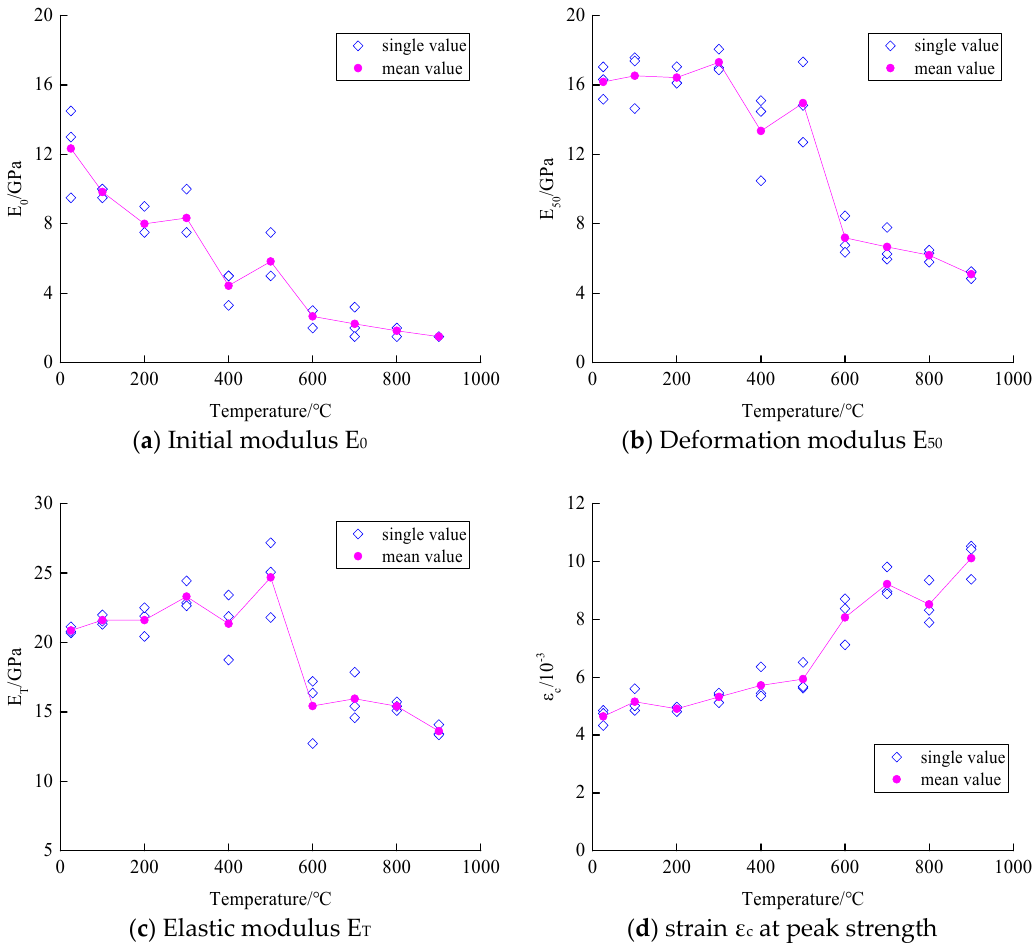
Figure 9. Relationship between uniaxial compressive deformation parameters and temperature.